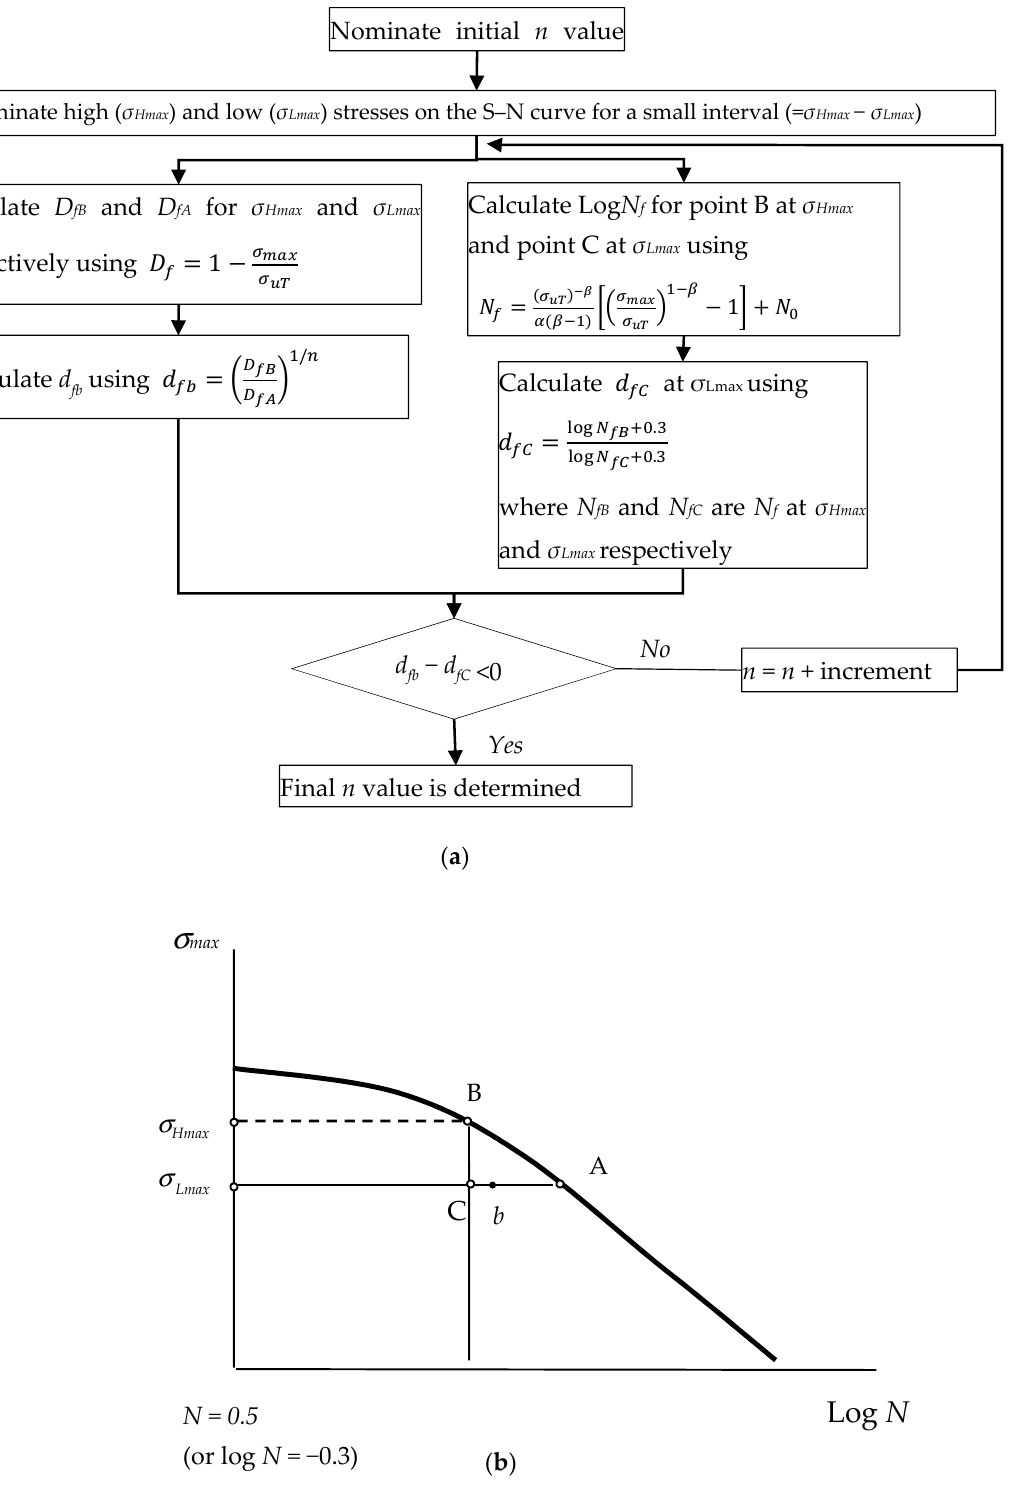
Figure 1. Calculation and notation: ( a ) sequence for finding exponent n value at given high ( σ Hmax ) and low ( σ Lmax ) stresses; and ( b ) notation on schematic S–N plane.